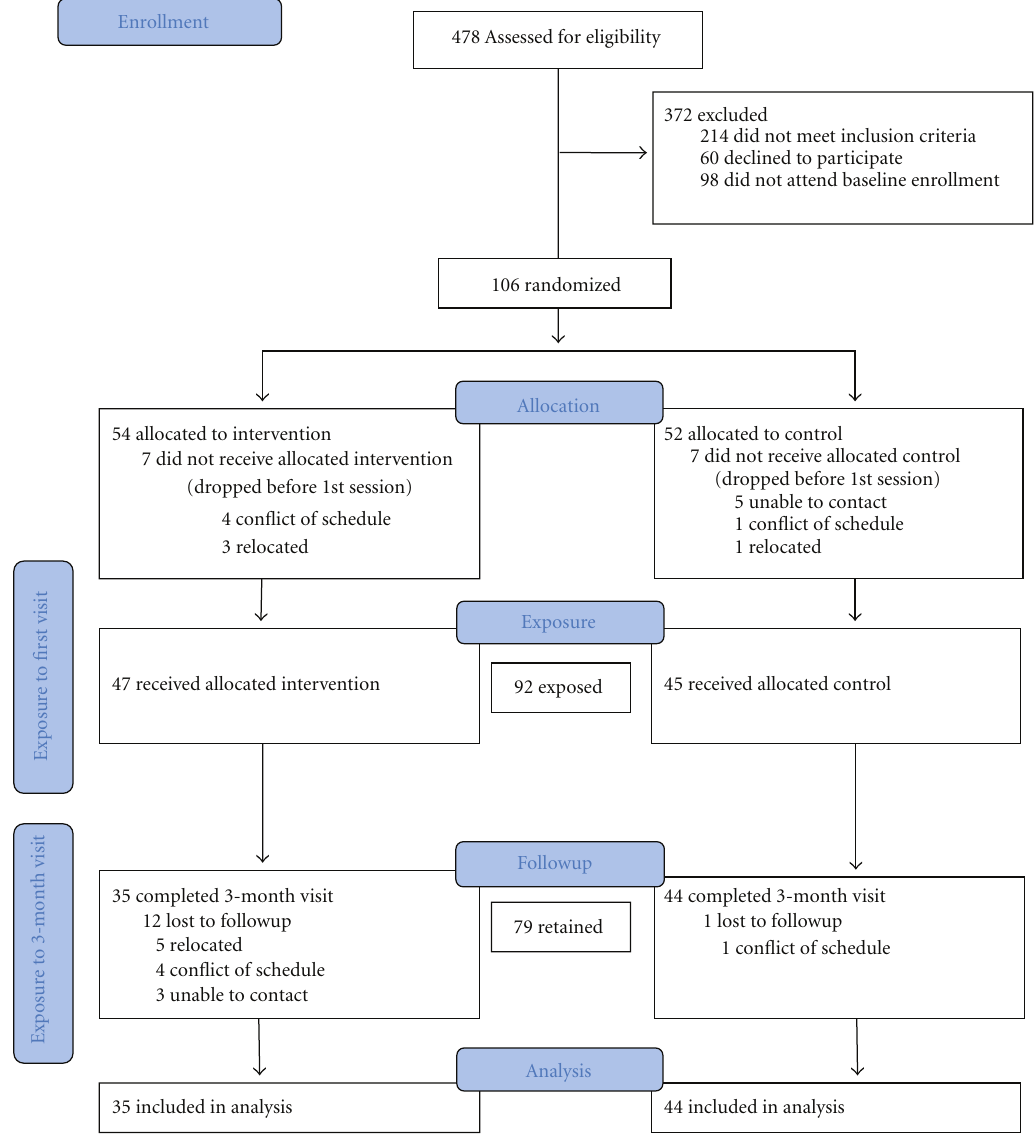
Figure 1: Flow of participants through the